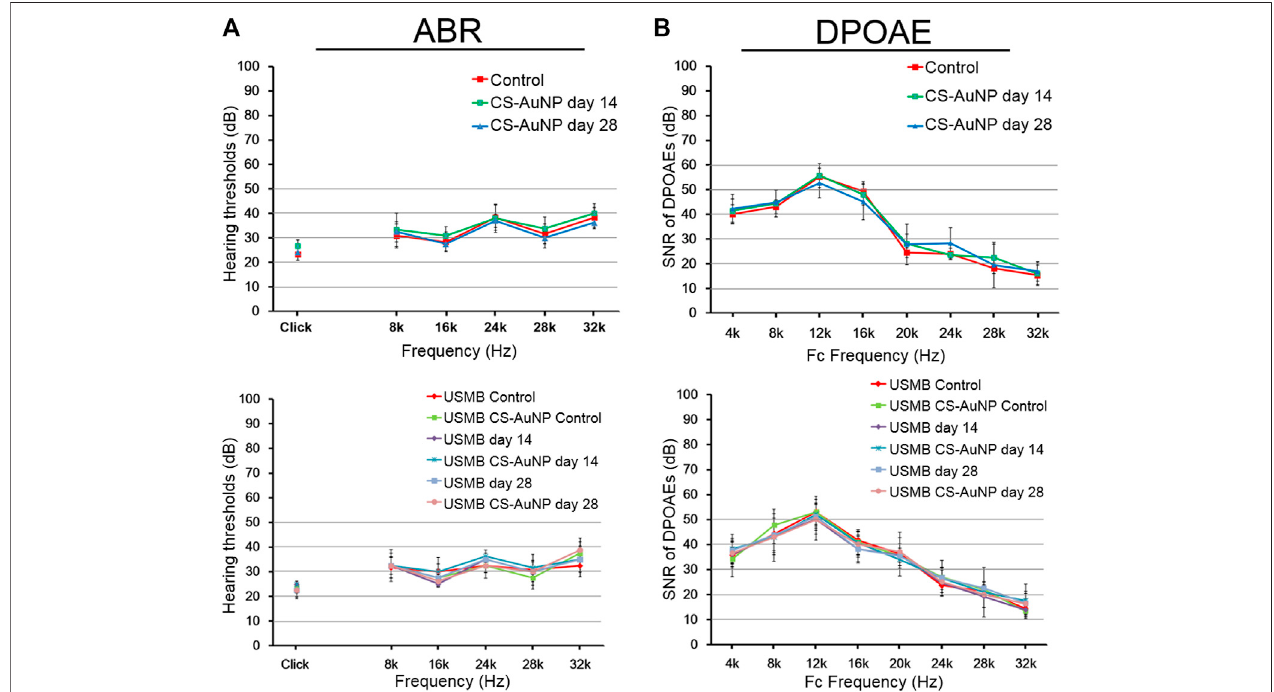
FIGURE 14 | Hearing assessment in mice treated with CS-AuNPs with or without prior USMB exposure. (A) The ABR threshold recordings during the 28-day follow-up in the RWS and USM groups before (day 0) and after USMB exposures. (B) SNRs of the cubic difference distortion product (2F 1 – F 2 ) at various center frequencies (F C ) for each group. The results are expressed as the mean ± standard error of the mean, with n (cid:2) 4 for each bar. DPOAE, distortion-product otoacoustic emission; USMB, ultrasound microbubble; CS-AuNP, chitosan-coated gold nanoparticle; ABR, auditory brainstem response; SNR, signal-to-noise ratio.